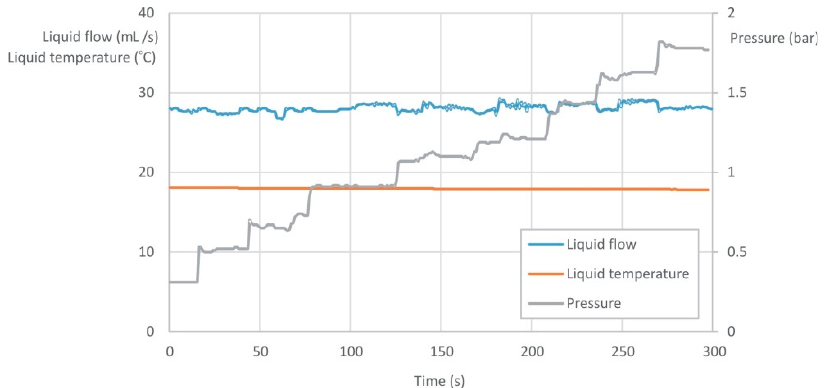
Figure 15. The exemplary dependence of liquid flow rate, liquid temperature and pressure on time for the different gas flow conditions (pressure rising).